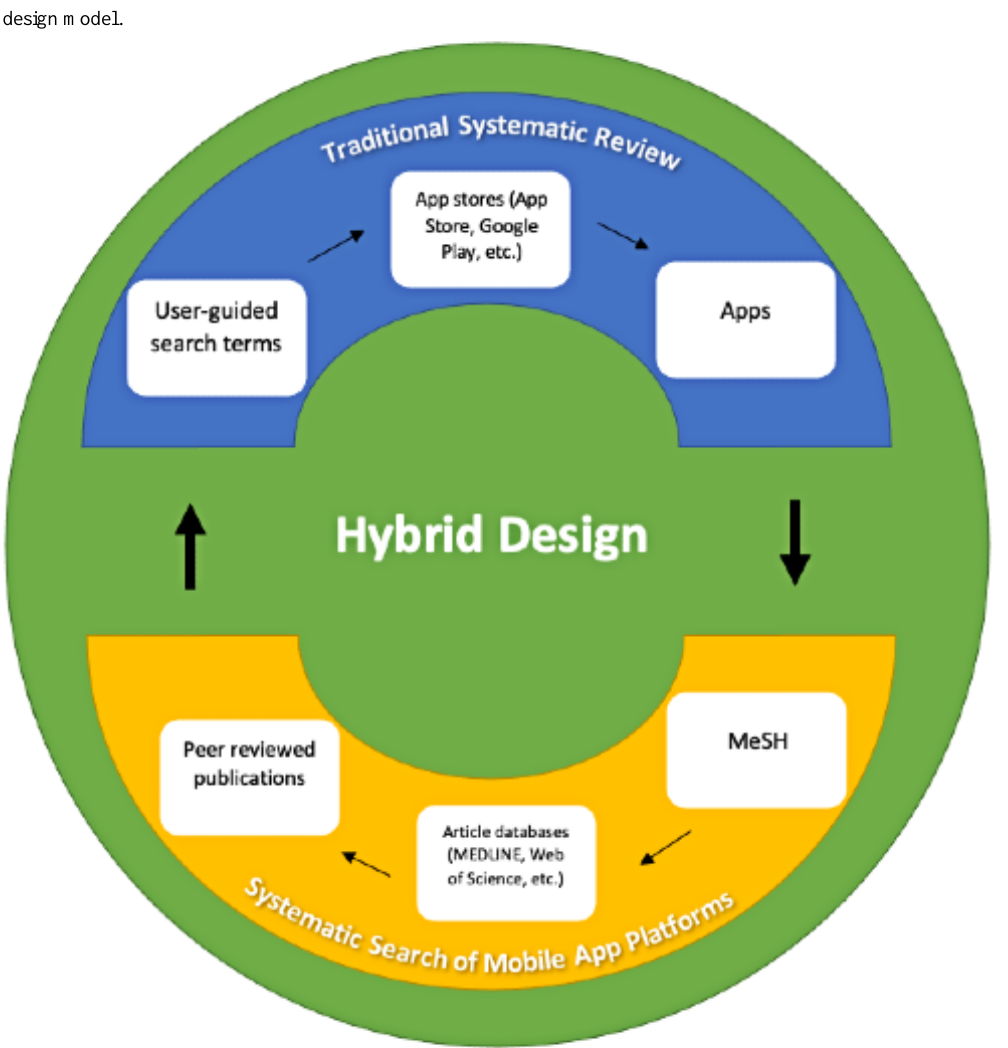
Figure 1. Hybrid design